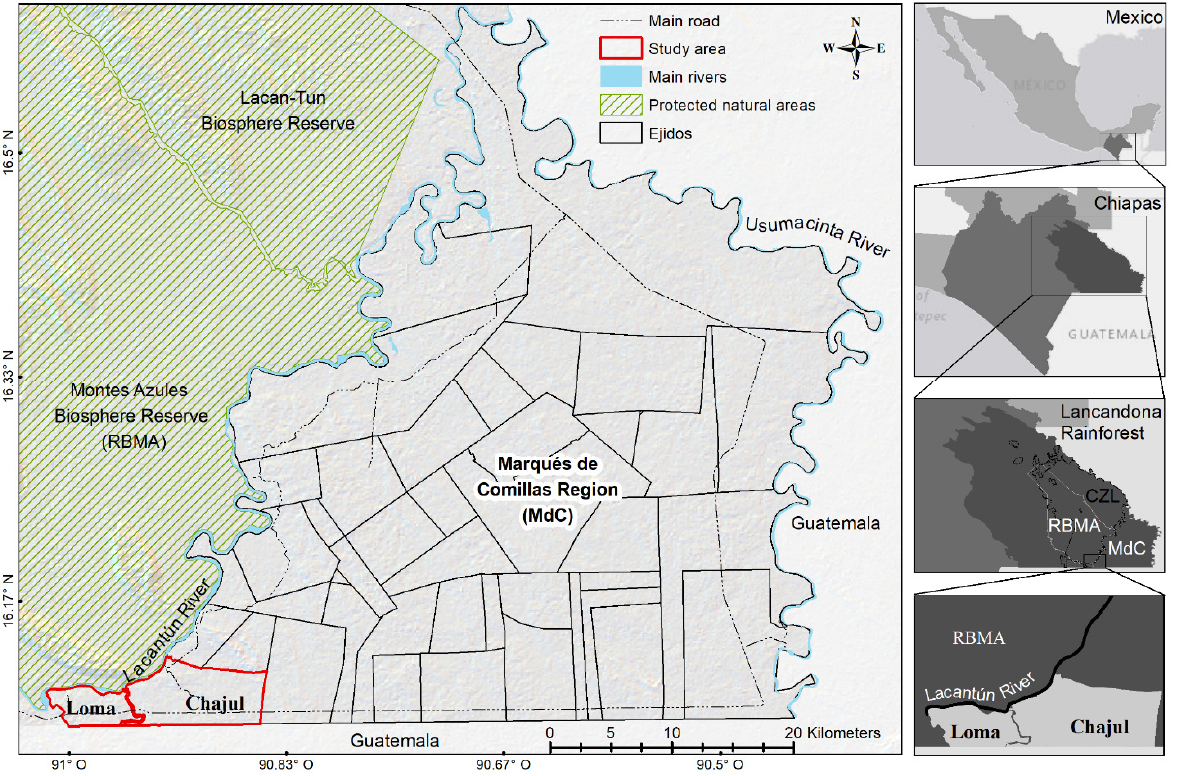
Figure 1. Map of the study area. Location of Loma and Chajul in the MdC region, southern Lacandona Rainforest, Chiapas, Mexico. Source: rivers [24]; roads [25]; ejido limits [26]; protected natural areas [27].